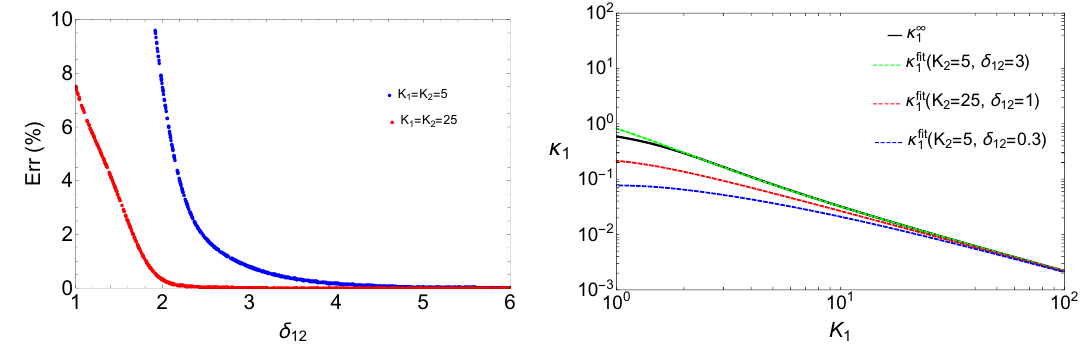
Figure 3 . Left: possible error due to (cid:20) (cid:12)t function of (cid:14) 12 . Right: comparision of (cid:20) (cid:12)t